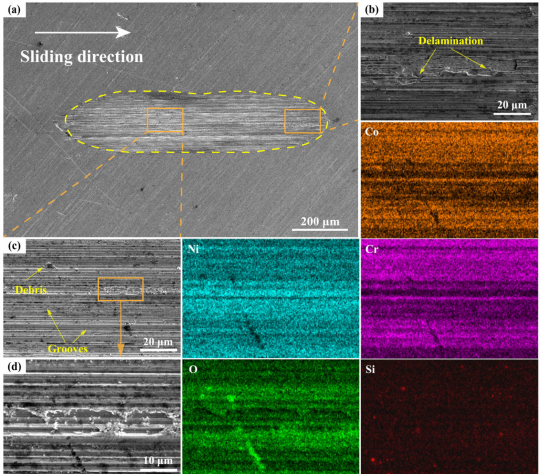
Figure 8. SEM and EDS micrographs of overall morphology ( a ) and some details ( b - d ) of the wear track for CoCrNi tested at an applied potential of − 0.42 V.